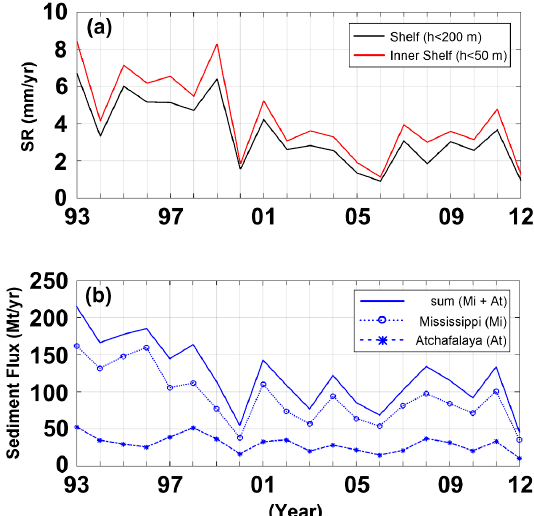
Atchafalaya Rivers; ( b )). 200 m; black) and inner shelf (water depth < 50 m; red), and fluvial sediment flux (Mississippi and